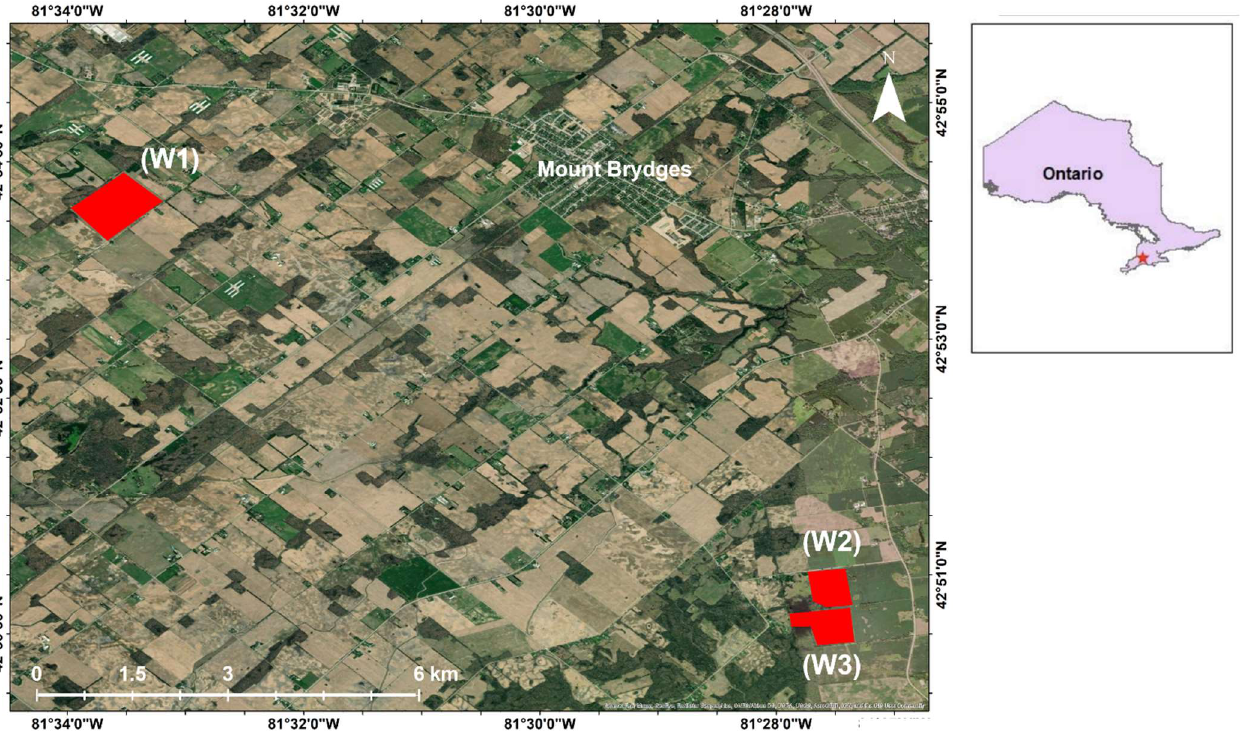
Figure 1. Location of the three 2020 wheat fields near Mount Brydges in southwestern Ontario, Canada, over a Google Earth image. Table 1. Summary of fieldwork data